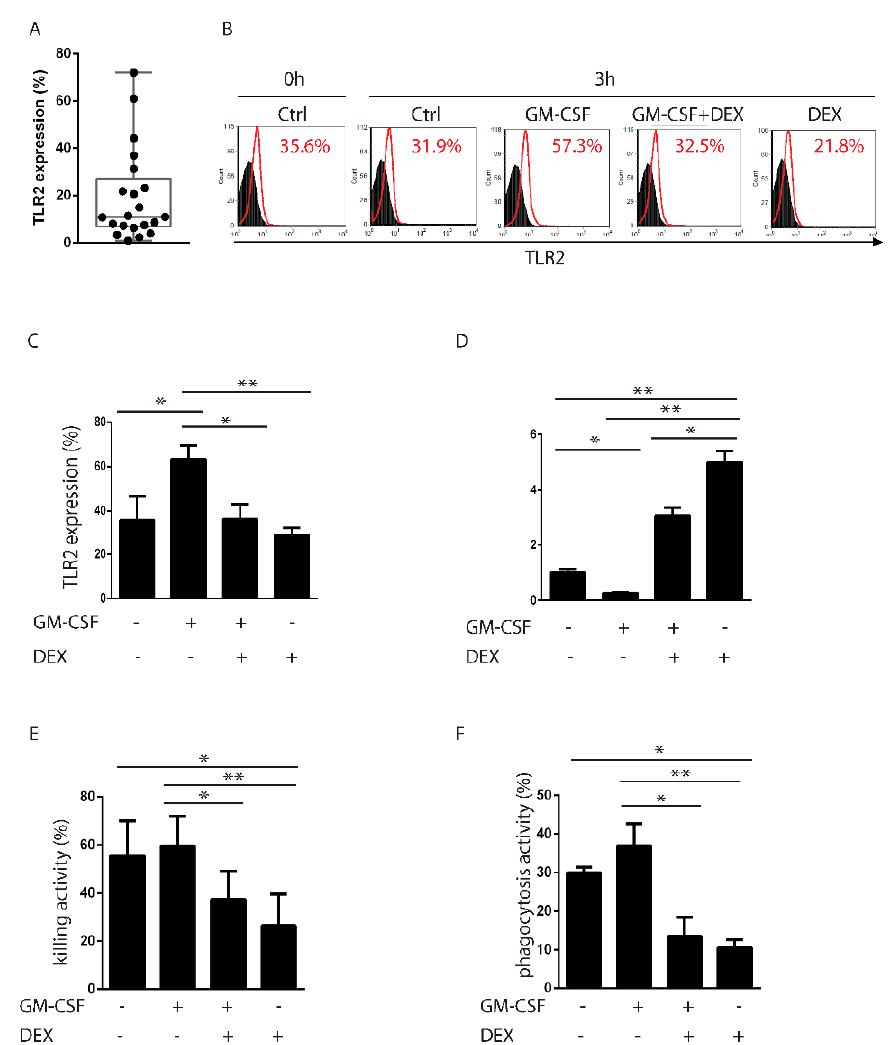
Figure 5. DEX downregulates TLR2 in human neutrophils. ( A ) Flow cytometry evaluation of TLR2 expression on human neutrophils (PMNs) isolated from buffy coats ( n = 21). ( B ) In vitro treatment with the granulocyte-macrophage colony-stimulating factor (GM-CSF) upregulates TLR2 after 3 h (percentage of total cells), whereas DEX downregulates TLR2, either alone or in combination with GM-CSF. One representative staining is shown. ( C ) Summary and mean values of TLR2 expression as described in B. Values represent the mean ± SD of three independent experiments. ( D ) Quantitative RT-PCR of GILZ expression in PMNs under the same experimental conditions as described in ( A ). ( E , F ) Killing activity and phagocytosis, respectively, of PMNs treated in vitro with GM-CSF or DEX, either alone or in combination, or left untreated for 3 h. Values represent the mean ± SD of three independent experiments. * p < 0.05; ** p <